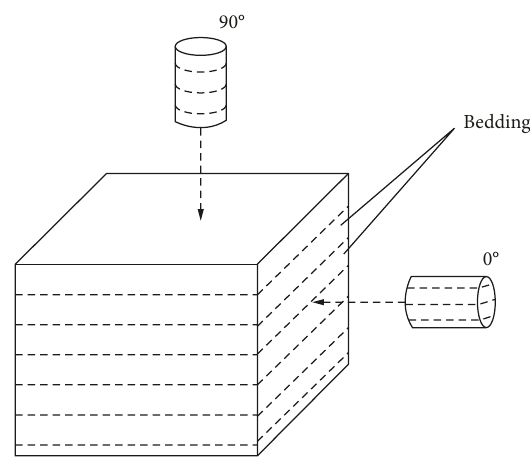
Figure 1: Schematic diagram of coring of the shale